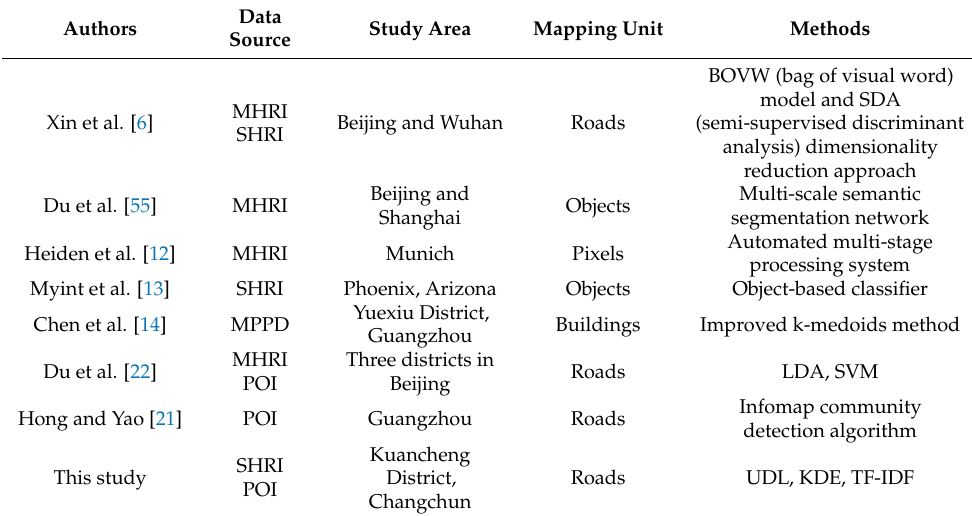
Table 4. Comparison with existing